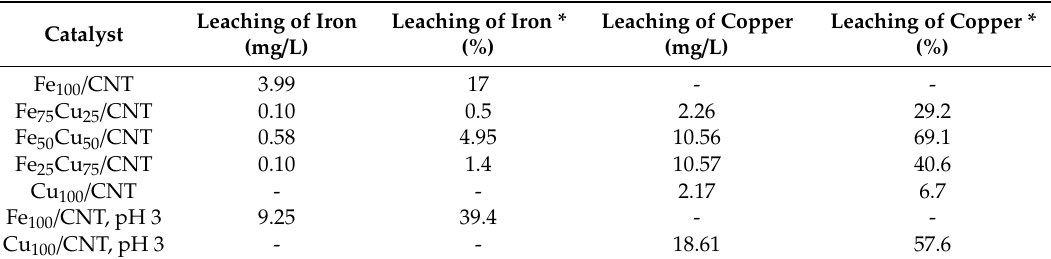
Table 5. Leaching of metals after 5 h of reaction determined by inductively coupled plasma mass spectrometry